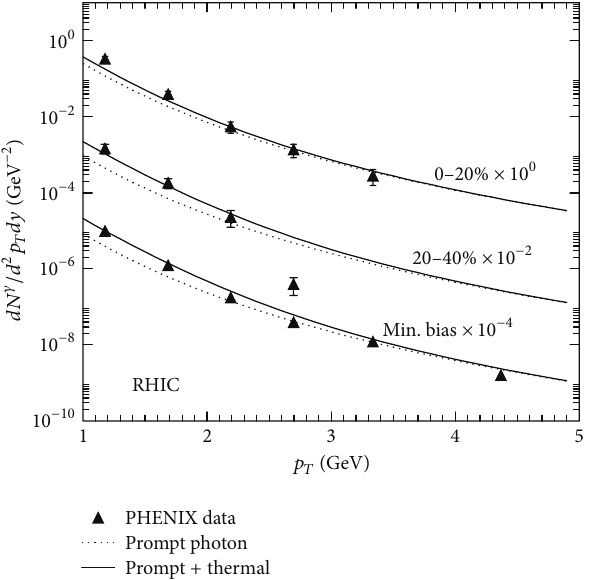
Figure 8: Transverse momentum spectra of photons at LHC energy for Pb-Pb collision for different 0–40% centrality at midrapidity [59].